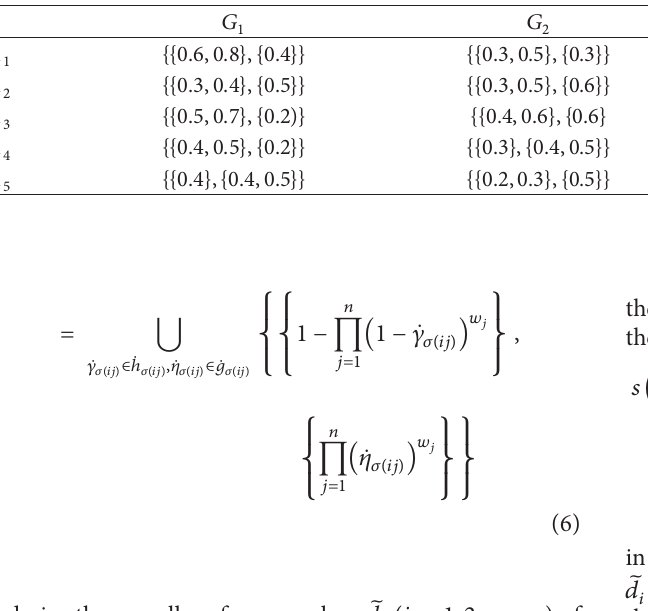
Table 1: Dual hesitant fuzzy decision